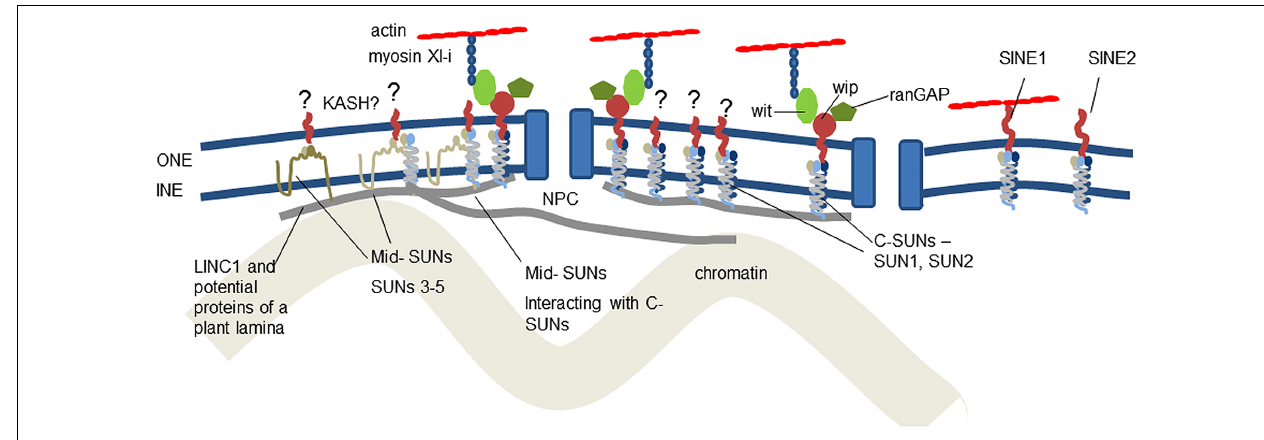
constitute a key component of anchorages for the cytoskeleton, nucleoskeleton, and nuclear pores. Anchorage of SINE, Wit, Wip, and RanGAP all depend on SUN interaction. The plant LINC complexes are involved in two actin-NE linkages – the direct SINE1-actin connection and the WIP-WIT-myosin XI-I – actin